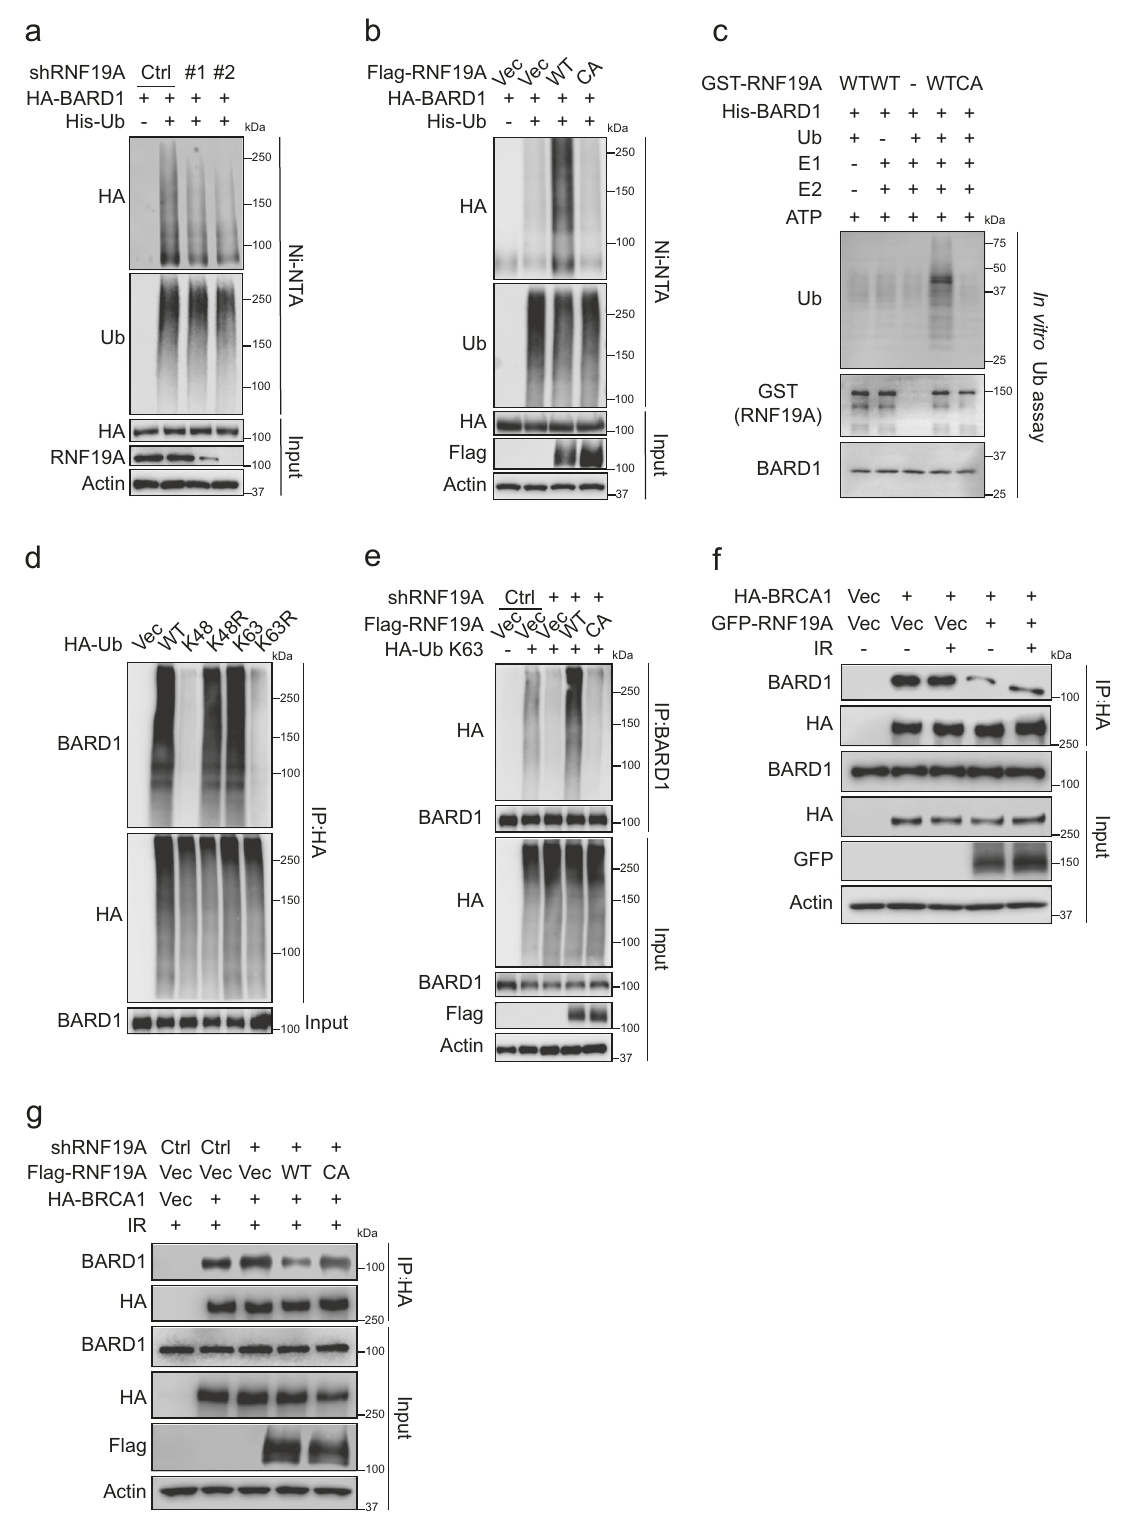
(Fig. 3i) in BARD1-de fi cient cells. Altogether, our results suggest that RNF19A regulates HR-mediated repair in a BARD1- dependent manner. RNF19A promotes ubiquitination of BARD1 and dissociation of the BRCA1/BARD1 interaction . As RNF19A regulates resection and HR in a catalytic- and BARD1-dependent manner,